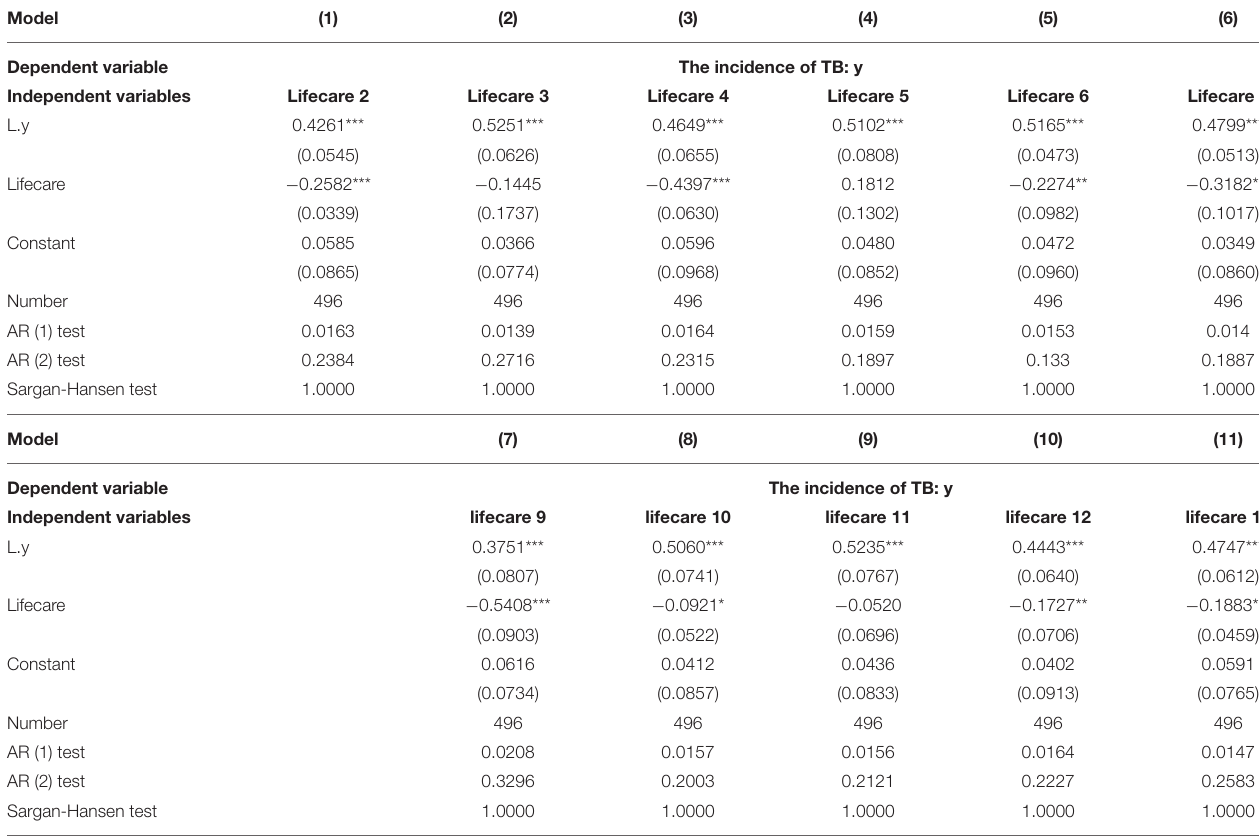
TABLE 6 | Estimated results of the impact of lifecare variables on the incidence of tuberculosis.